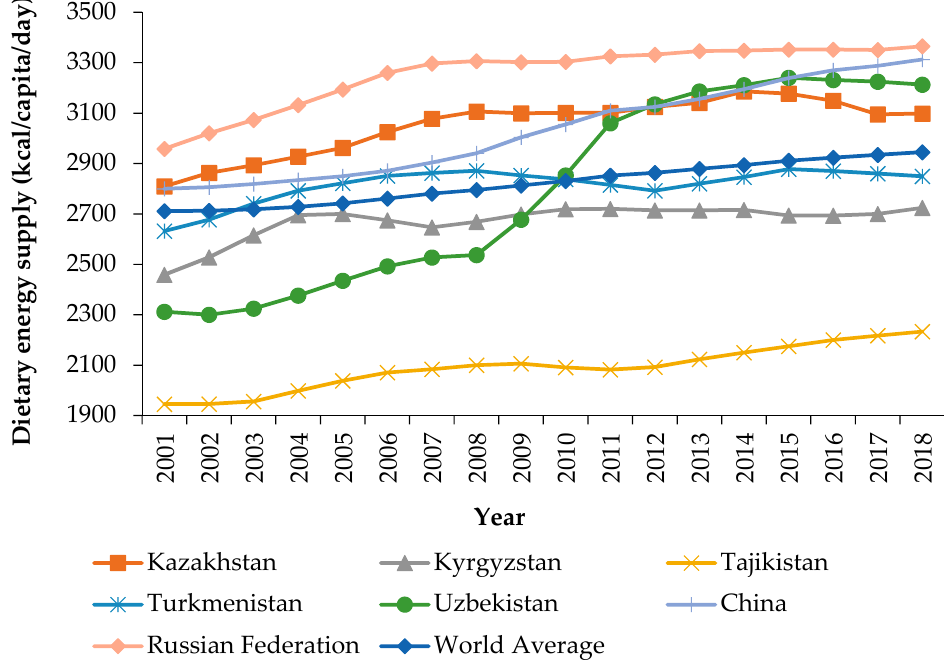
Figure 1. The “availability” pillar of food security in Central Asian countries, China, the Russian Federation, and the world average from 2001–2018. The x-axis represents the year. The y-axis refers to food security’s “availability” pillar, which is denoted by the dietary energy supply.